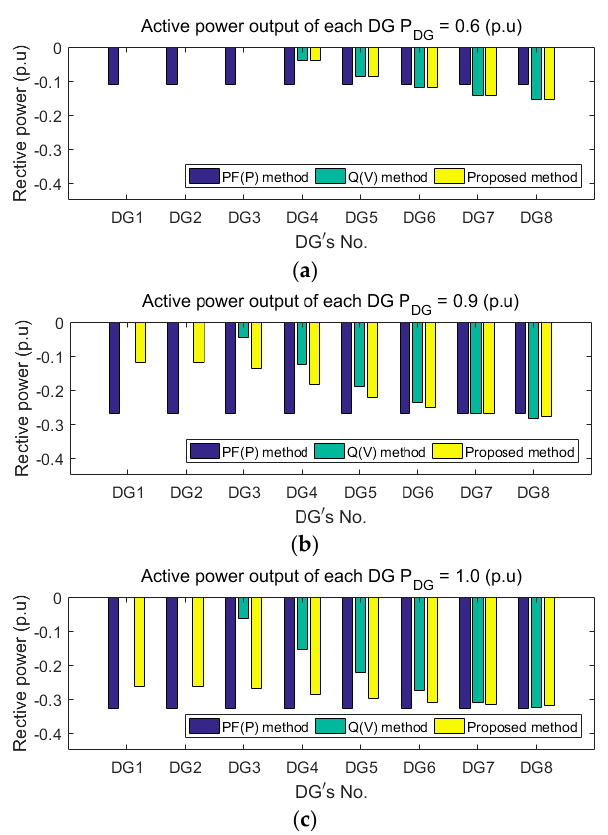
Figure 12. Reactive power absorption amounts for each DG by the reactive power control methods when the active power output is ( a ) 0.6 p.u.; ( b ) 0.9 p.u.; and ( c ) 1.0 p.u.